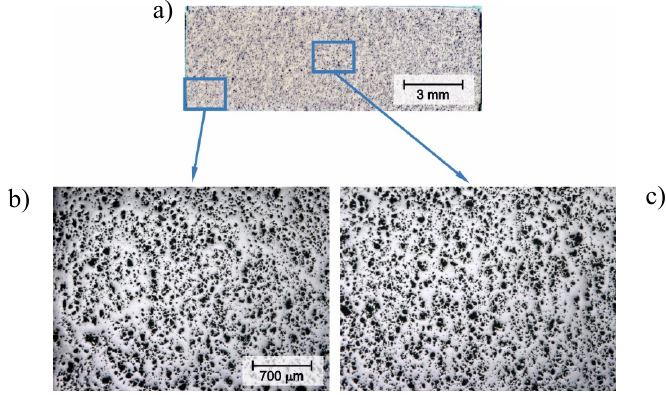
Figure 9. ( a ) Macrograph, and micrographs showing the porosity distribution at ( b ) the corner and ( c ) center of a diametrical section of a compact conventionally consolidated.